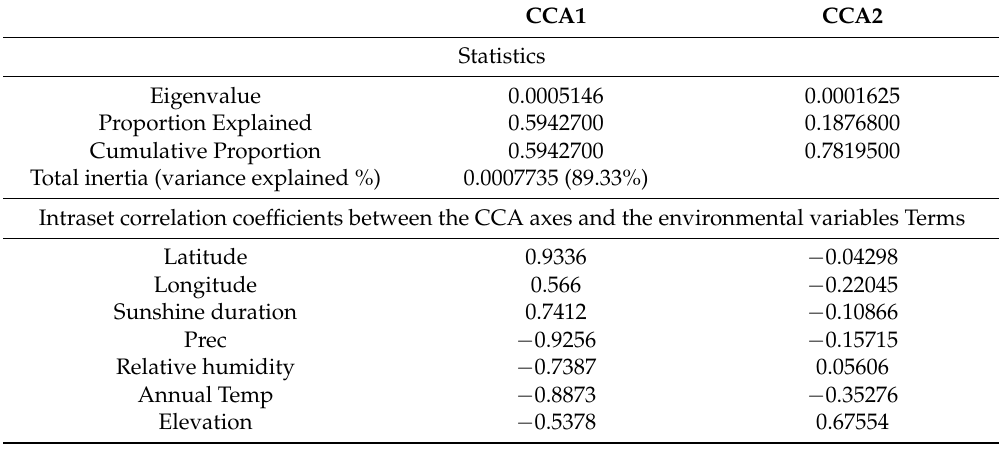
Table 6. ANOVA of key factors in the canonical correspondence analysis (CCA) model. Explanatory Variable Environmental